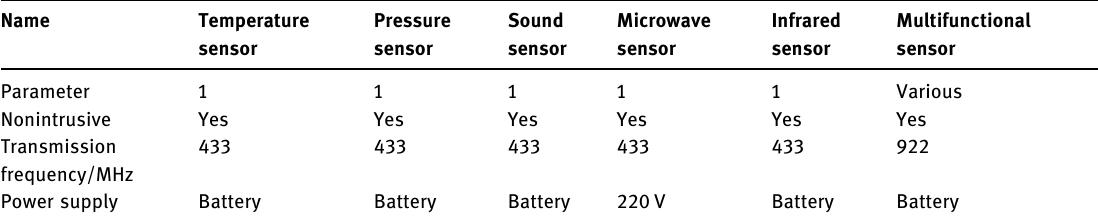
Table 3: Sensor con fi guration